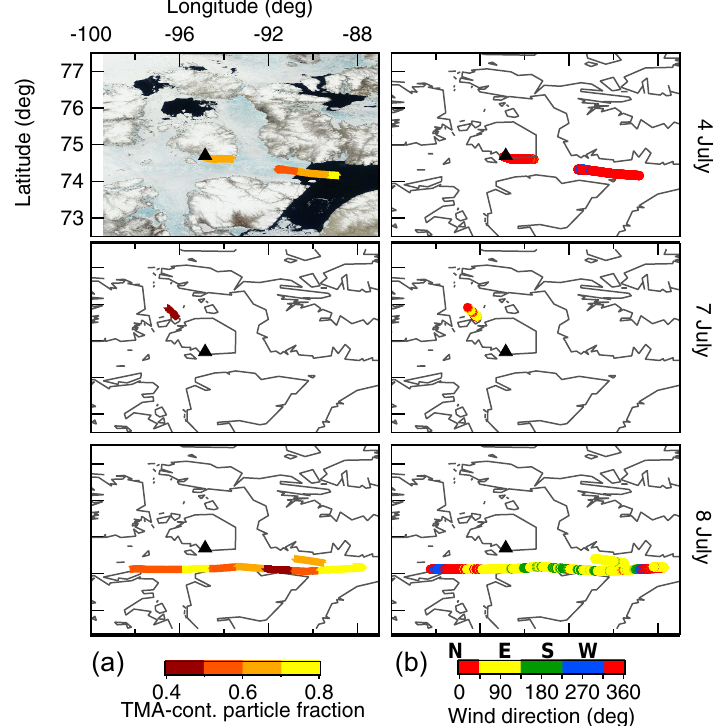
Figure 16. Spatially resolved fraction of TMA-containing particles ( a , color-coded) and wind direction ( b , color-coded) below 340m. Different rows present different measurement days. The first graph additionally shows the satellite image on 4 July in the visible range. Further satellite images are not presented here due to negligible changes in sea ice coverage from 4–8 July. Abbreviations N, E, S and W refer to north, east, south and west. The black triangle presents the location of Resolute Bay on the